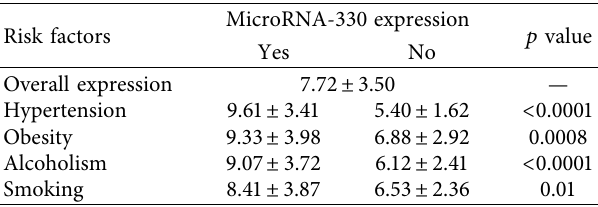
Table 4: Comparison of microRNA-330 expression with different risk factors among T2D cases.